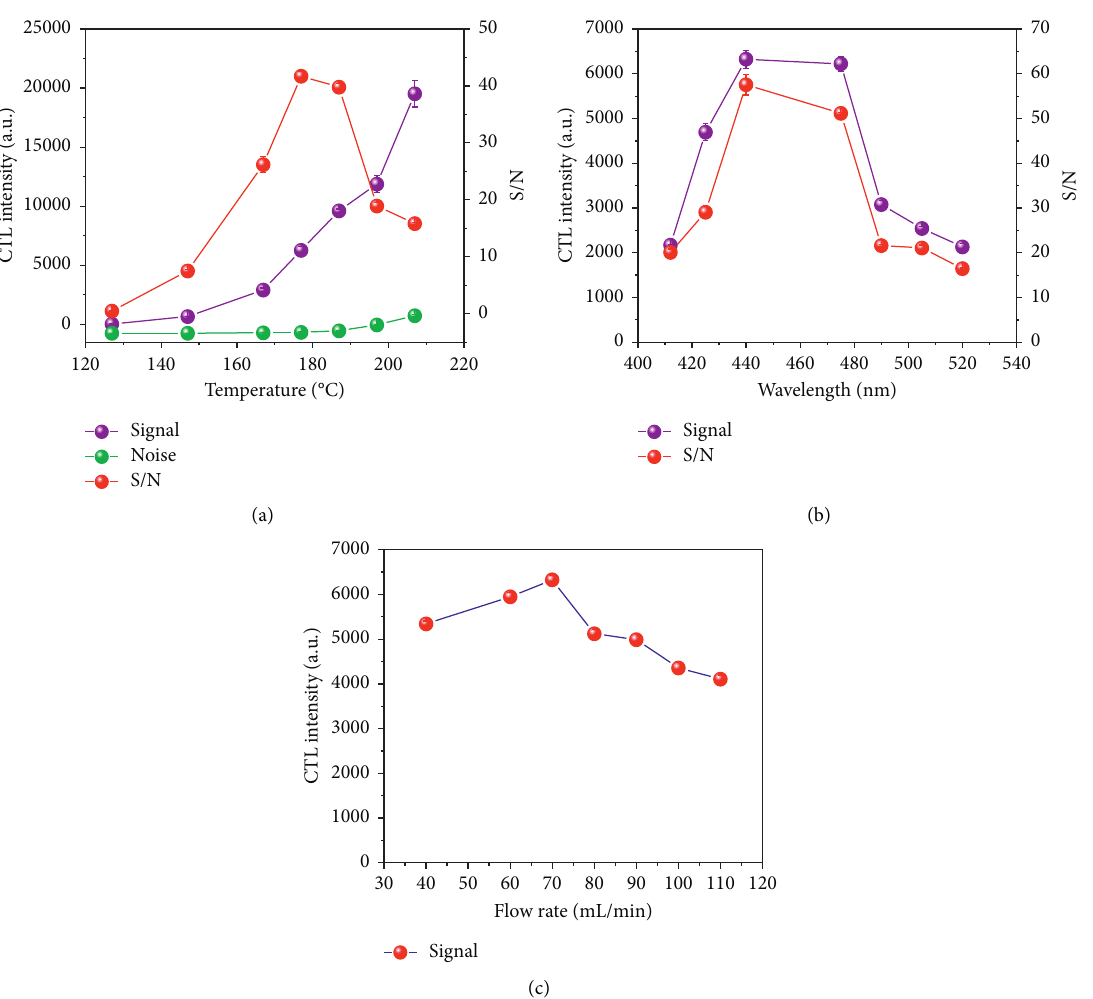
Figure 5: Effect of detection conditions on CTL intensity, noise, and S/N. (a) Effect of working temperature on CTL intensity, noise, and S/N; (b) effect of wavelength on CTL intensity and S/N; (c) effect of air flow rate on CTL intensity.